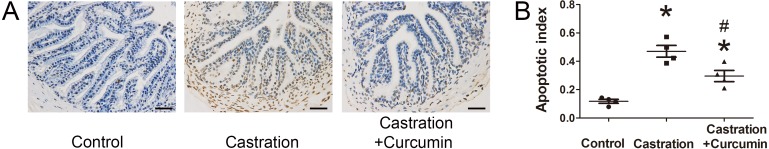
TUNEL staining and apoptotic index.(A) Representative image of terminal deoxynucleotidyl transferase 2′-deoxyuridine 5′-triphosphate nick end labeling (TUNEL) staining (400×, scale bar = 50 µm). (B) Apoptosis index detected with TUNEL staining; n = 4 for each group. *P < 0.05 compared with control group. # P < 0.05 compared with castration group.